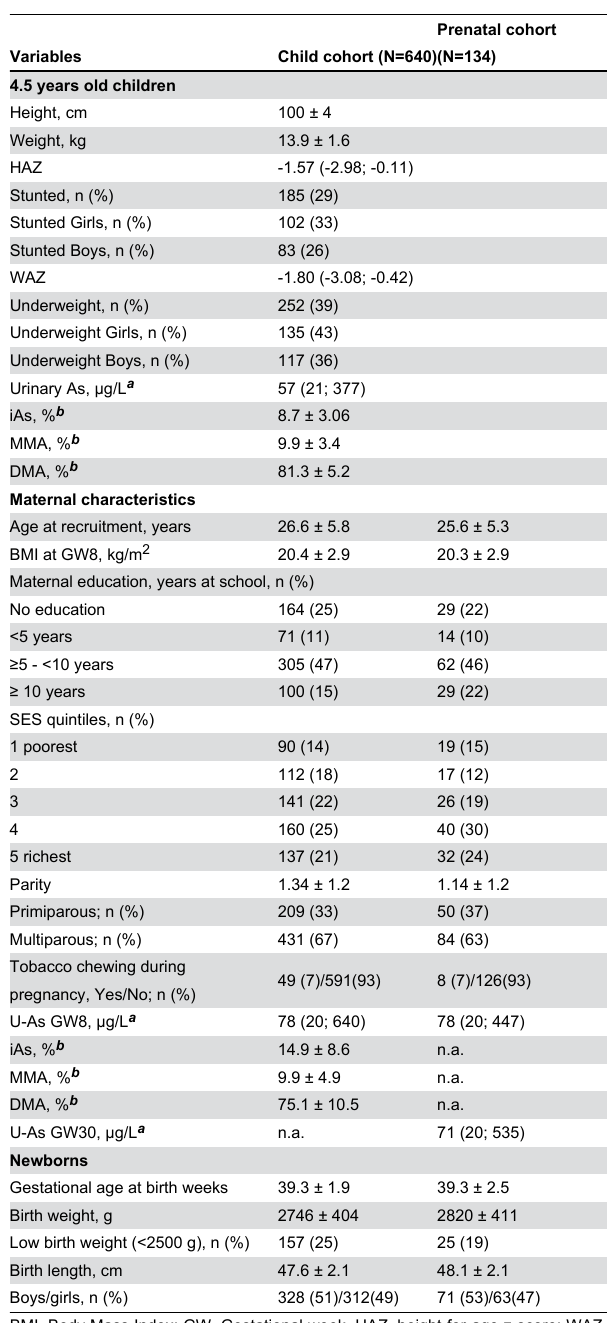
Table 1. Characteristics of the study